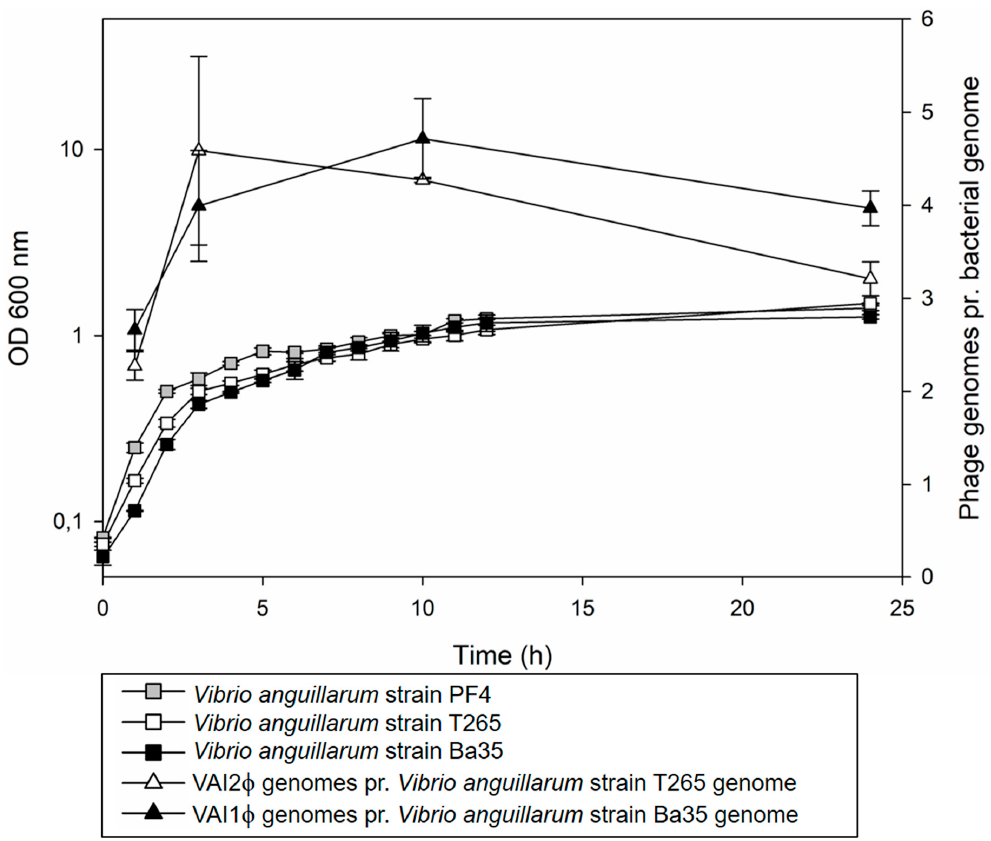
Figure 3. Bacteria growth and replication of phage genomes. The relative amount of zot and dnaJ was quantified by qPCR in cultures of Vibrio anguillarum strains. The zot dnaJ -1 ratios in T265 and Ba35 were normalized to the measures of V. anguillarum strain PF4- zot -prophage + , which appears to contain a stable non-inducible zot -encoding prophage. After normalizing to PF4- zot -prophage + , the relative gene quantities in T265 and Ba35 can be interpreted as an estimate of phage genomes ( zot ) pr. bacterial genome ( dnaJ ). Error bars indicate the standard deviation of biological triplicates.